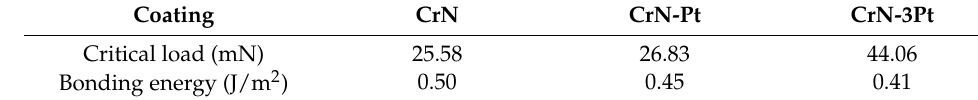
Figure 16. Comparison of the maximum value and gradient of the maximum residual tensile stress S11 on the surfaces of the three coatings. ( a ) S11 residual stress; ( b ) S11 residual stress gradient.